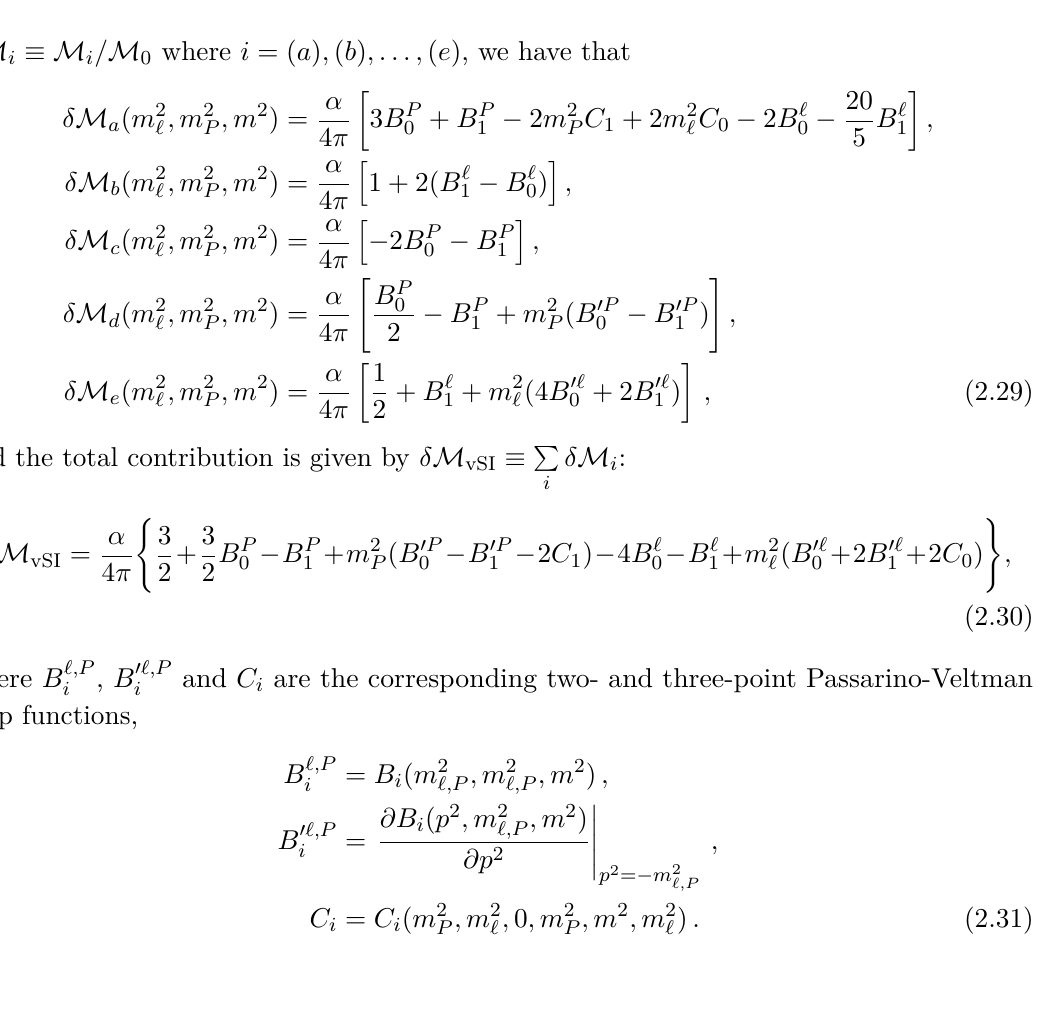
Figure 2 . Structure-independent or point-like meson corrections to τ − → P − ν τ . Notice that the contribution of diagram ( f ) vanishes after the meson mass renormalization. A similar set of diagrams also describes the virtual corrections to the P → µν decays with the proper replacements dictated µ by crossing